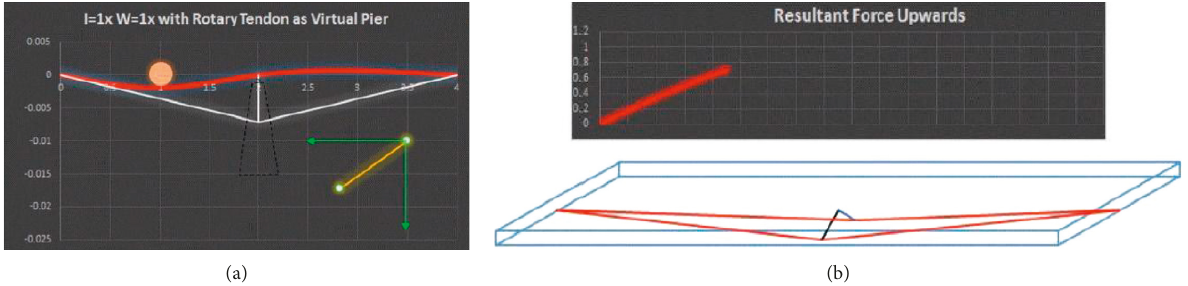
Figure 3: Rotation angle and upwards resultant force for the second stage of a bridge with the NEM.